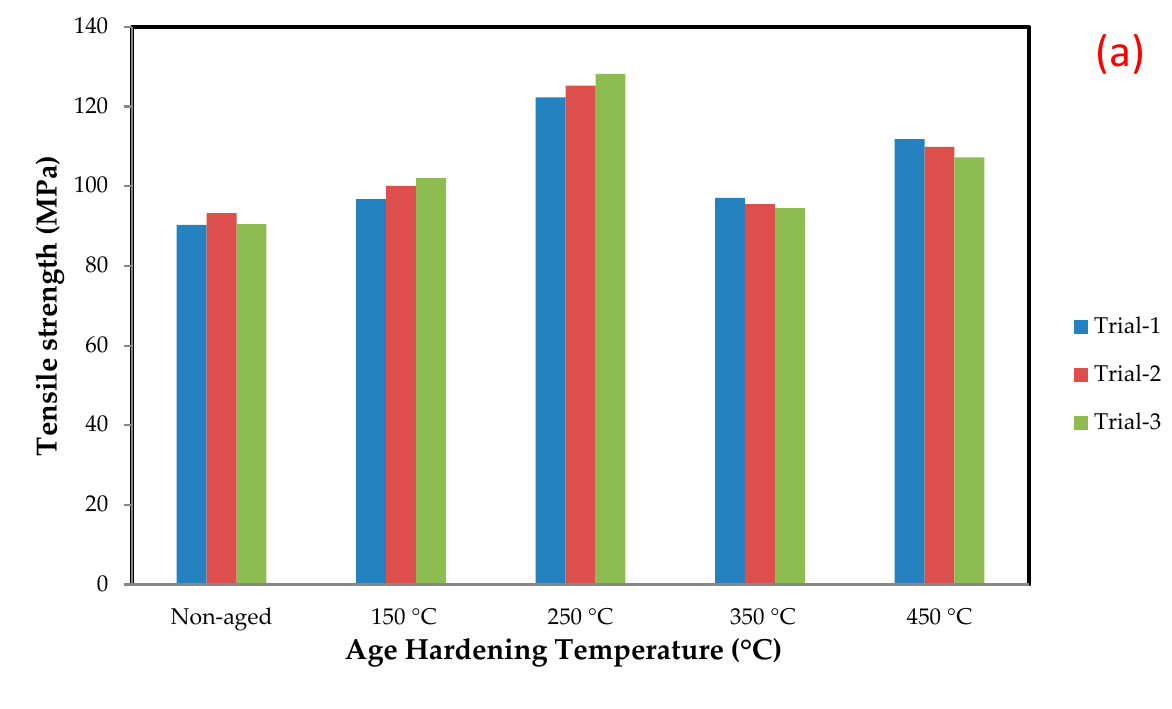
Figure 5. Stress strain curve of non-aged and aged composites at 150, 250, 350 and 450 °C.